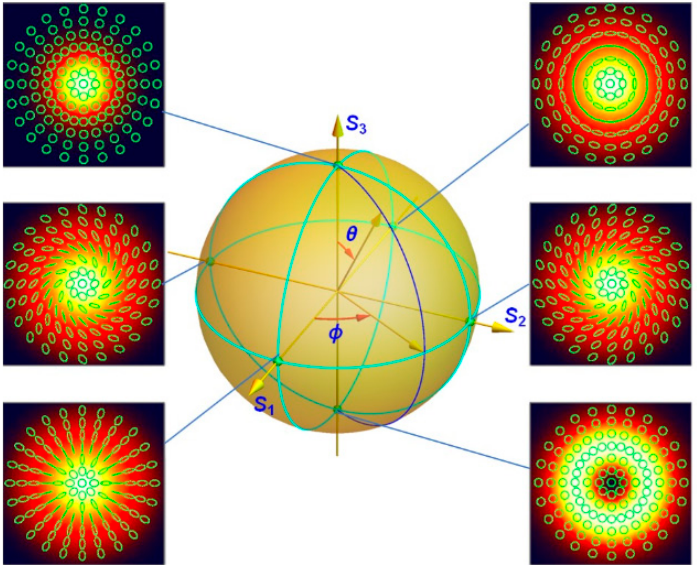
Figure 2. Schematic illustration of the hybrid-order Poincaré sphere with 𝑙 = 0 and 𝑚 = 2 . The polarization and intensity distribution of vector vortex beams corresponding to four points on the equator and two poles.